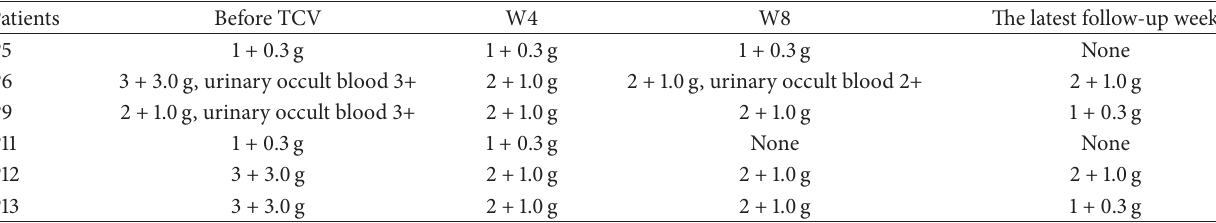
Table 2: The changes in urinary protein and occult blood.